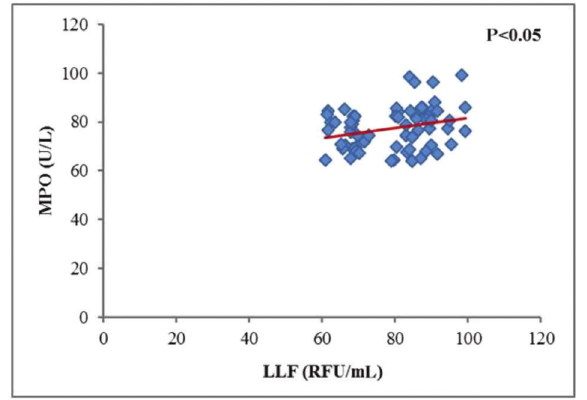
Figure 3. Correlation between malondialdehyde (MDA) and glutathione peroxidase (GPx) activity in serum of patients with hypertension and age-related cataract (n=69, r=0.250, P o